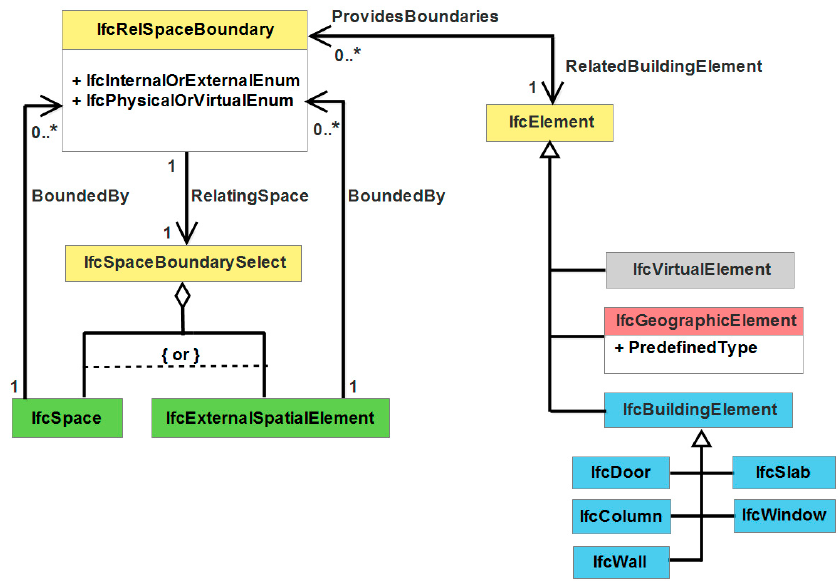
Figure 4. Entities for modelling building elements and functional spaces in the IFC Figure 3. Entities for modelling building elements and functional spaces in the IFC standard.